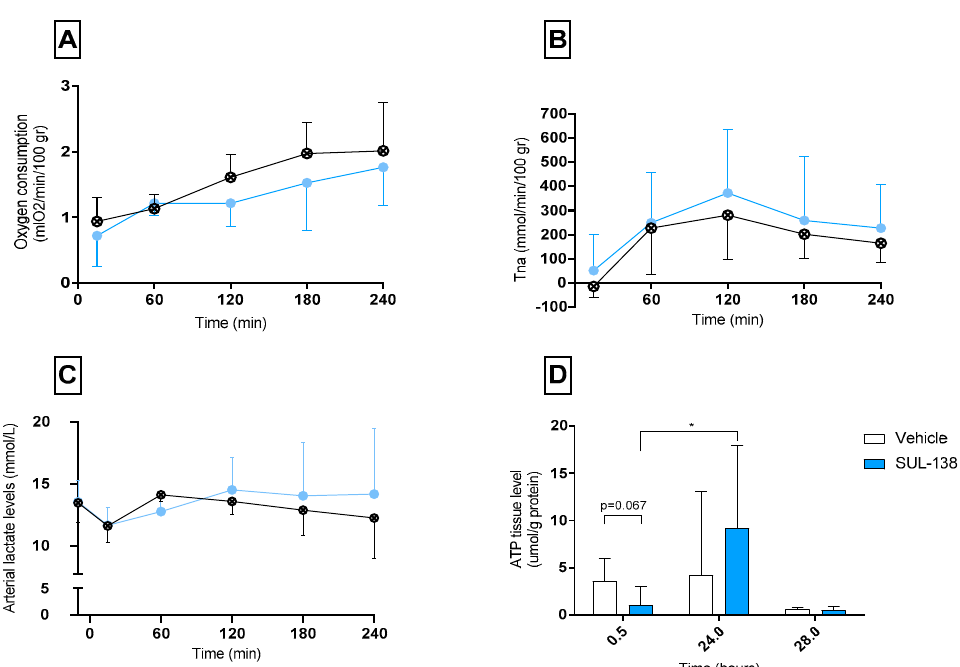
Figure 3. Parameters dependent on mitochondrial function. Parameters were assessed in porcine kidneys that were preserved with 24 h of non-oxygenated hypothermic machine perfusion with (SUL—138 • ) and without (Vehicle ⊗ ) the addition of SUL—138, ( A ) Oxygen consumption rates during NMP, ( B ) Total sodium reabsorption rates during NMP, ( C ) Arterial lactate levels during NMP, ( D ) ATP levels were measured during the experiment after 30 min warm ischemia (timepoint 0.5), after 24 h HMP (timepoint 24) and at the end of 4 h NMP (timepoint 28), * p < 0.05 significant increase in ATP values during 24 h HMP with the addition of SUL—138. NMP, normothermic machine perfusion; ATP, adenosine triphosphate; WIT, warm ischemic times; ASAT, Aspartate Aminotransferase; AUC, Area under the curve. The data are shown as mean ± SD.